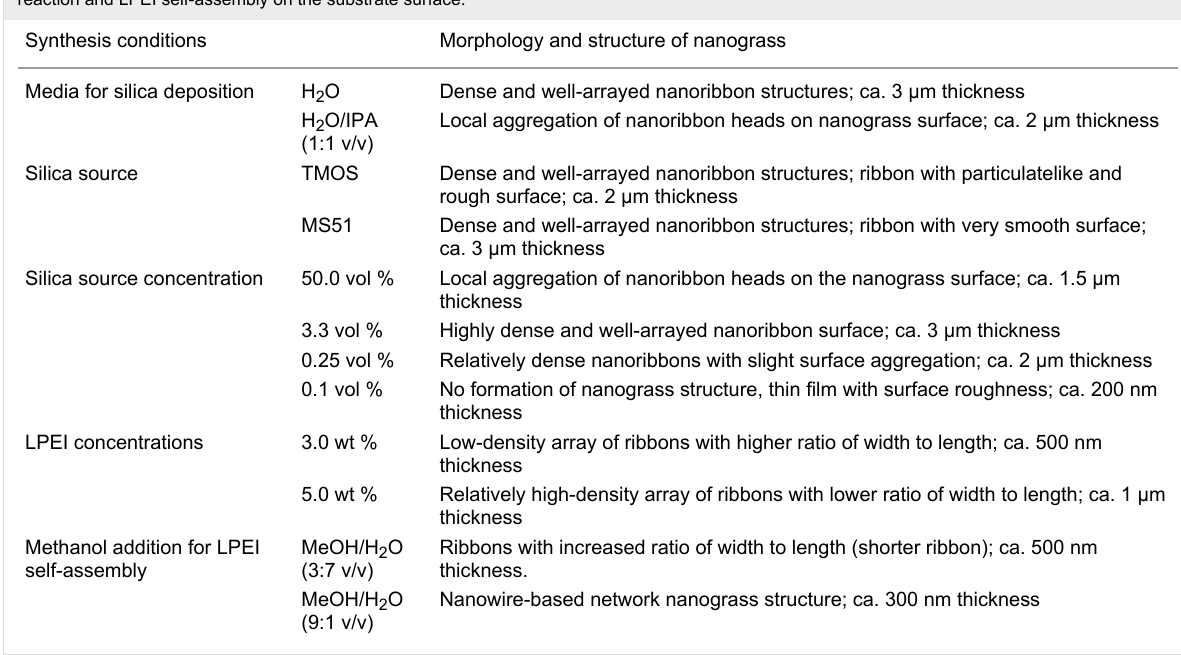
Table 1: Summary of surface morphology and nanostructure of LPEI@silica nanograss by adjustment of the conditions for the silica-mineralization reaction and LPEI self-assembly on the substrate surface. Synthesis